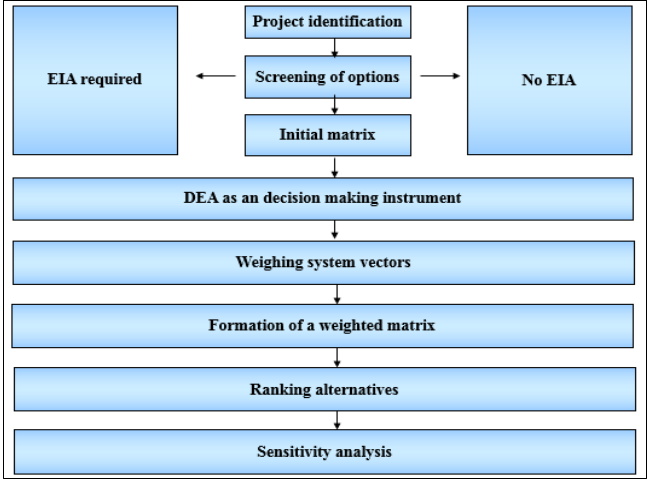
Figure 1: The evaluation steps of EIA and followed work for current